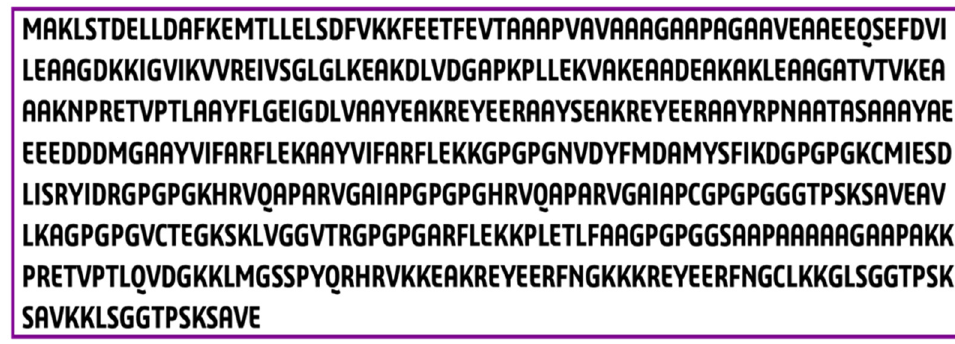
Figure 3. Constructed vaccine sequence.